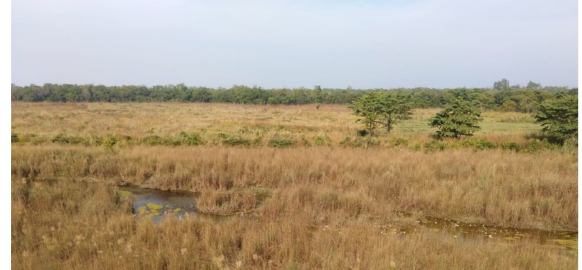
Figure A1. View from the tower (Bagh Machan). As entering these grasslands is not recommended, this view is used to assign ground truth locations for short grassland (patch on right-hand side), al- luvial tall grassland (in front, Saccharum spontaneum dominated), and mixed tall grasslands and riverine forest in the background. The location is northwest from the Khauraha phanta. Ground truthing was done in combination with satellite imagery to obtain the exact coordinates. The photograph was taken by the authors.